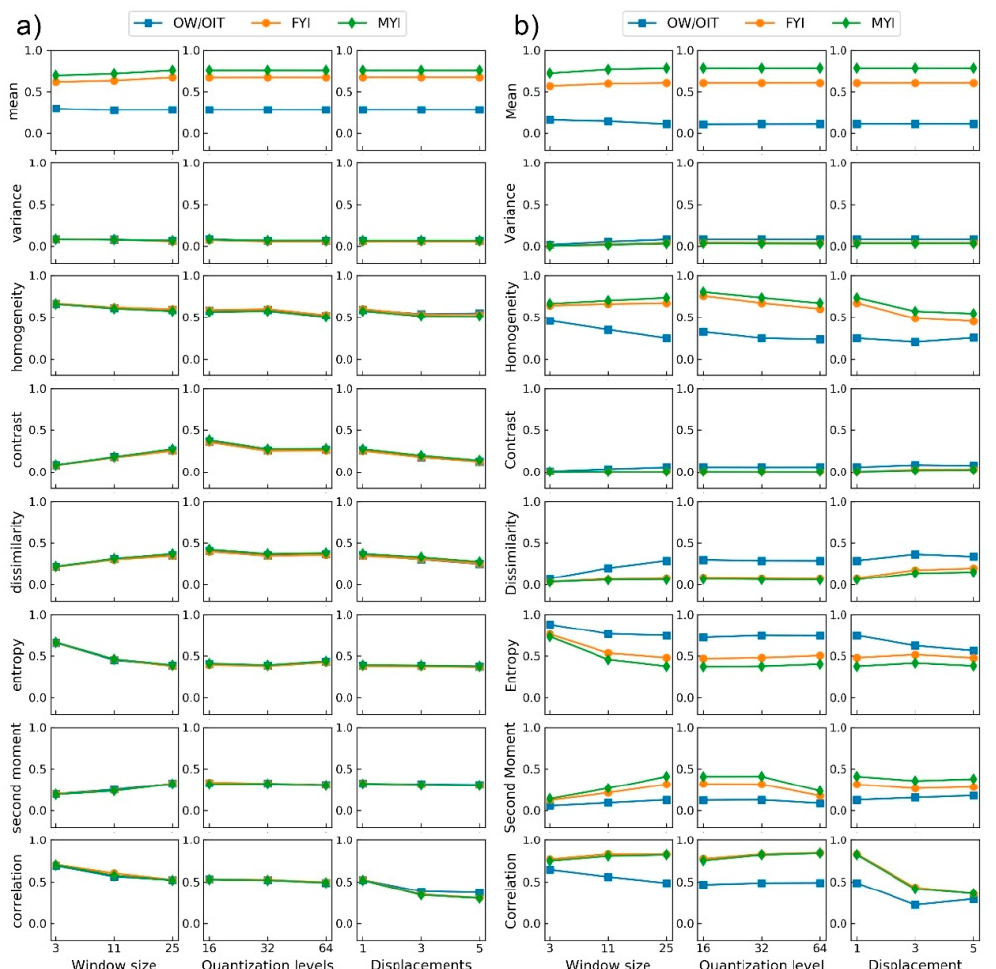
Figure 5. Values of the tested GLCM features for the three ice types FYI, MYI and OW / OIT for σ o ( a ) and σ o ( b ). Three sets of calculation parameters are given on the x-axis. The orientation parameter in all cases is 0°.